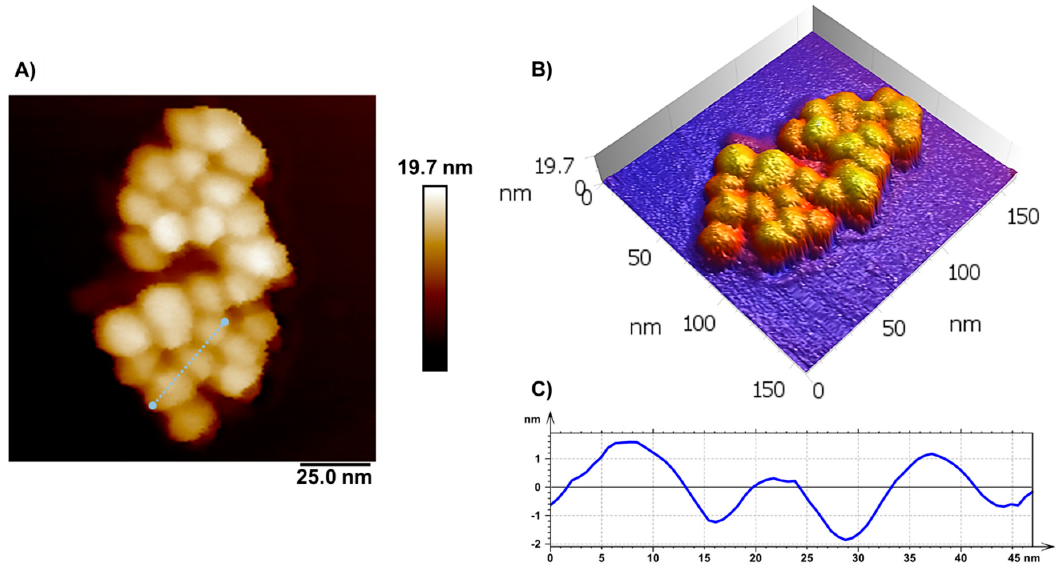
Figure 3. Topographic AFM image of [ 198 Au]AuNPs. ( A ) Heightmap of AuNPs cluster and ( B ) its respective three-dimensional visualization. ( C ) Cross section over the AuNPs in the corresponding region, highlighted in image ( A ) (dotted line in light blue). The particle diameter observed in the AFM measurements is compatible with the values observed in the DLS measurements.